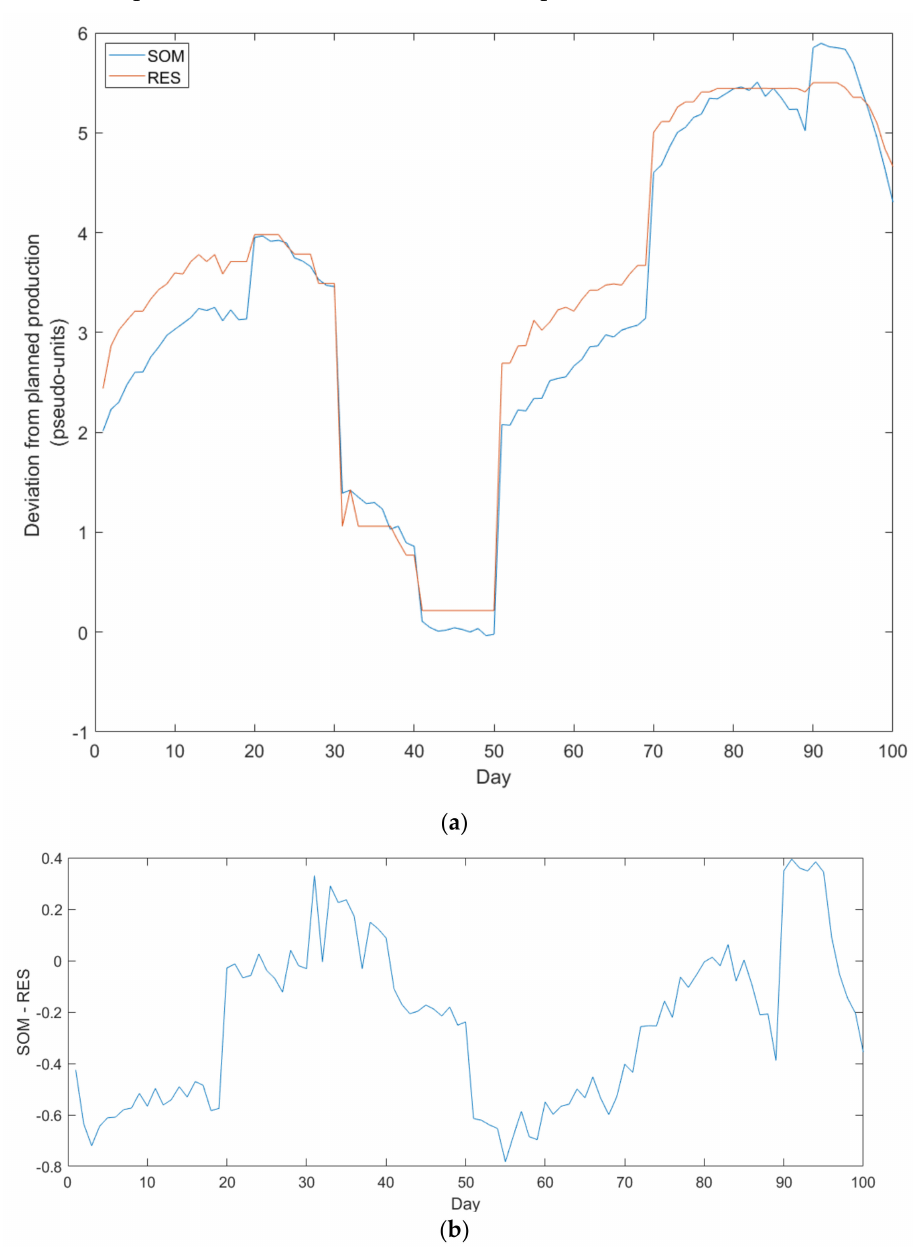
Figure 14. Results of the SOM prediction; good agreement between SOM prediction (blue) and RES model (red) is shown in ( a ), and the difference is shown in ( b